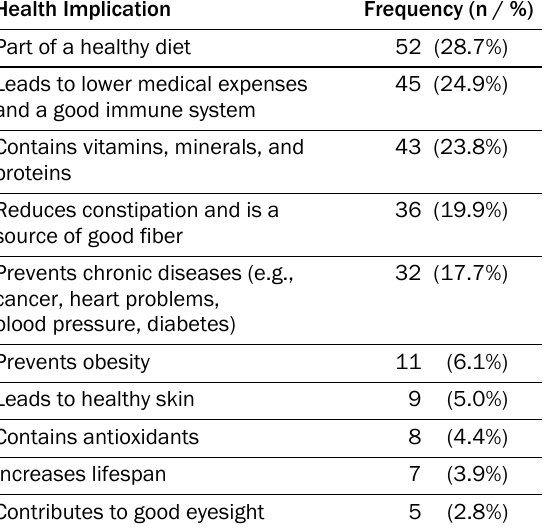
Table 4. Perception of Respondents on the Health Implications of Vegetables (N=250)